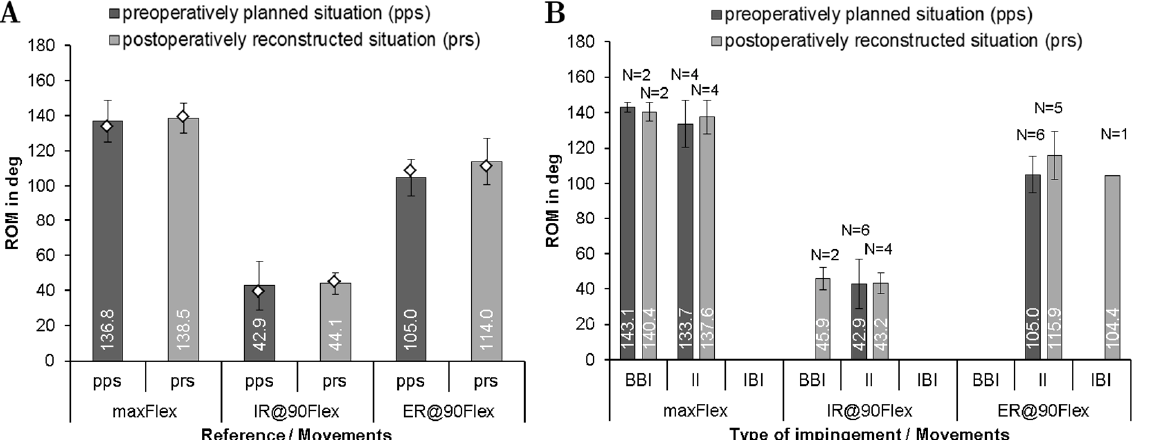
Figure 4. Comparison of the range of motion using implantation according to preoperatively planned situation (pps) and postoperatively reconstructed situation (prs) for each patient during maximum flexion (maxFlex), internal rotation at 90° of flexion (IR@90Flex), and external rotation at 90° flexion (ER@90Flex) for n = 6 patients. ( A ) Mean range of motion with standard deviations until impingement during the three movements for n = 6 patients. Note that the median of range of motion values are depicted as diamonds. ( B ) Quantity N of the impingement type (BBI, bone-to-bone impingement; II, implant-to-implant impingement; IBI, implant-to-bone impingement).